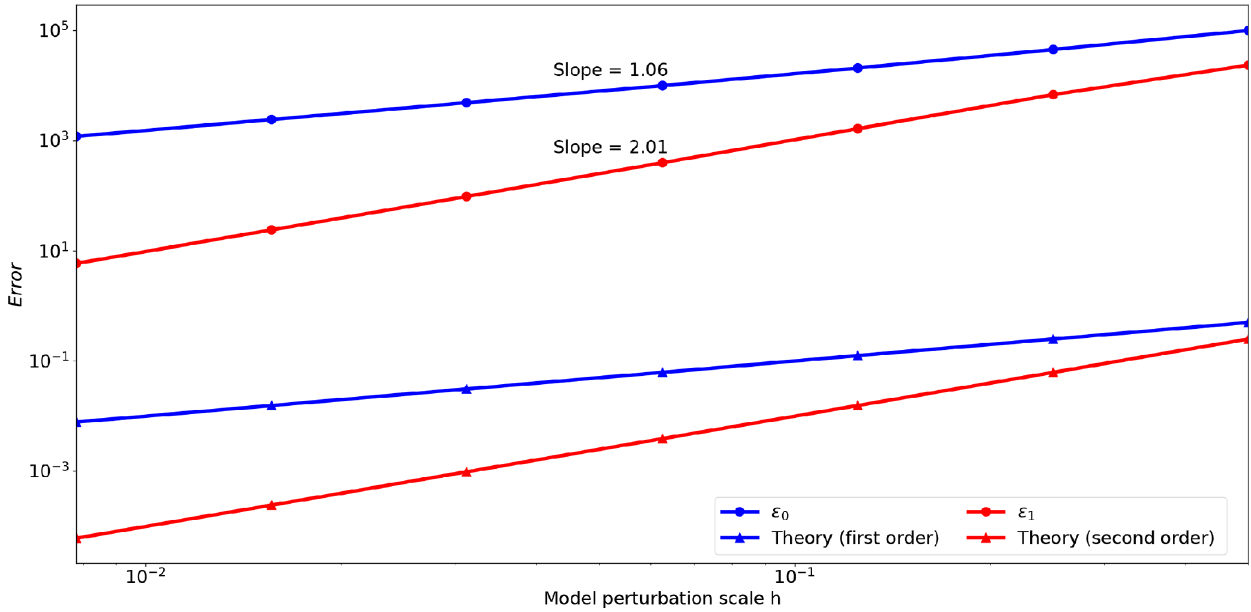
Figure 12. Gradient test for the acoustic propagator. The first-order (blue) and second-order (red) errors are displayed in logarithmic scales to highlight the slopes. The numerical convergence order (1.06 and 2.01) shows that we have a correct implementation of the FWI operators.